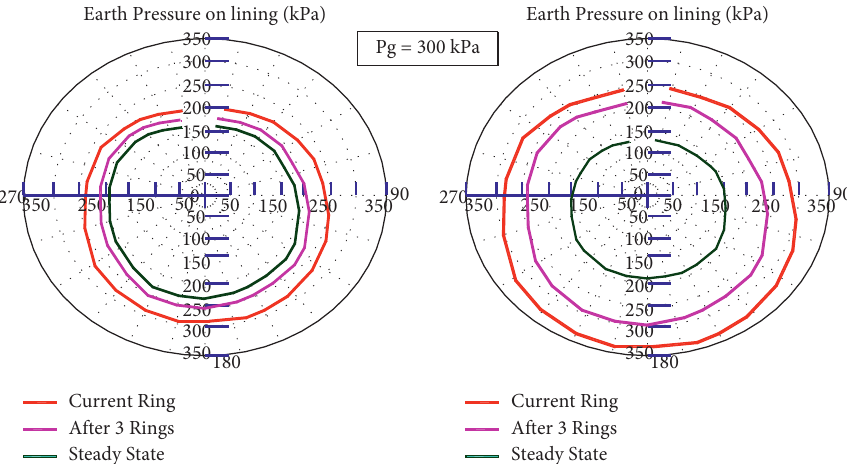
Figure 2: Spatiotemporal evolution (including earth and groundwater pressures) (reannotated based on literature [46]). Invading Force